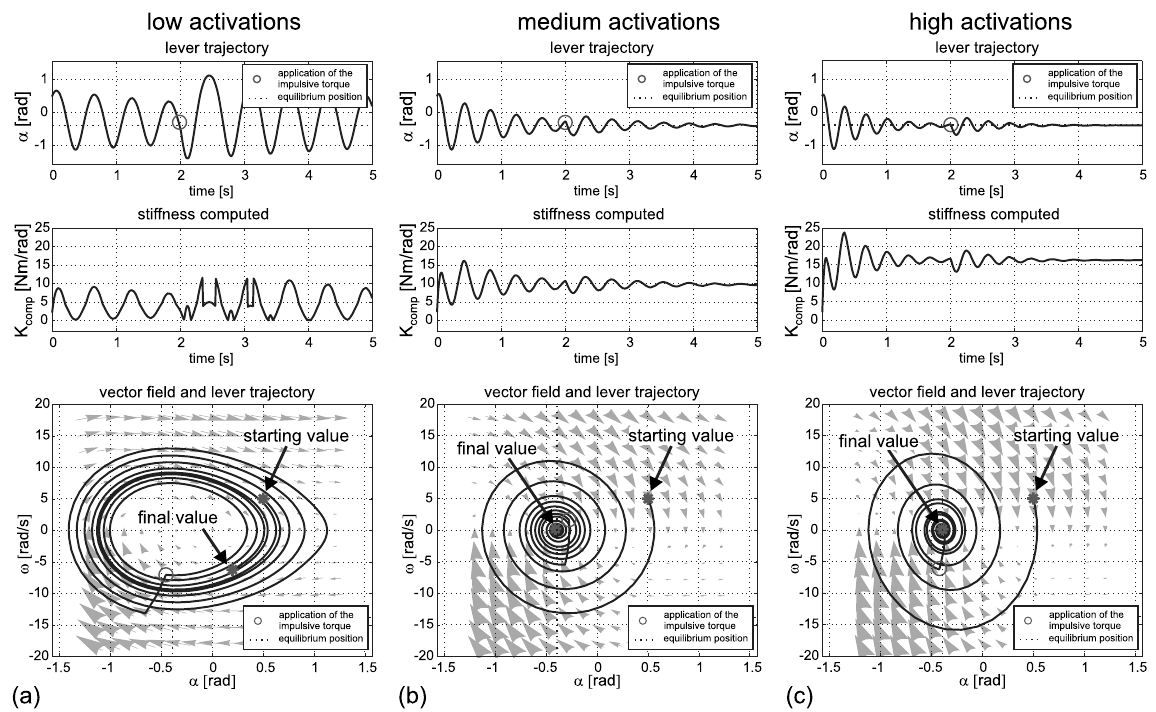
Fig. 3. Stability analysis of the hinge joint loaded by external forces for three different activation levels. In the top of the figure the lever trajectory and the stiffness computed are plotted over time. In the bottom are depicted the vector field and the lever trajectory. (a) depicts the simulation results in the case of muscles low activated. The equilibrium position is stable but oscillations are high. At t = 2s an impulsive torque is applied to the lever which increases limb oscillations. (b) same situation as (a) but for medium activations. Oscillations are more damped and the impulsive torque has a slighter perturbing effect on the limb. (c) same as (b) but for higher activations. High joint stiffness provides a stabilizing effect at joint level.